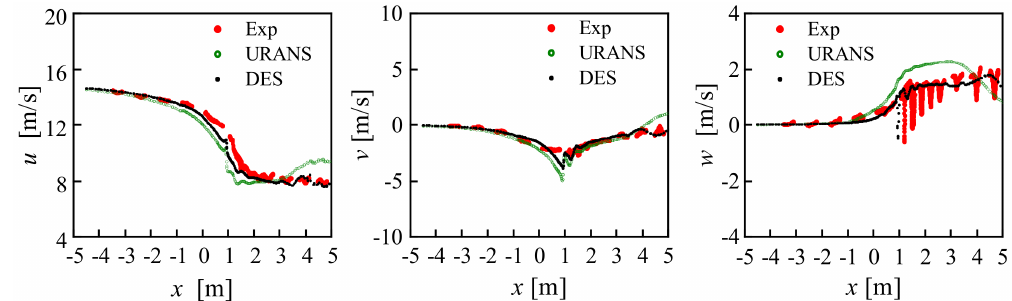
Figure 23. Axial profile of velocity components at y = − 1.5 m under wind speed of 15 m/s, TSR = 6.7.